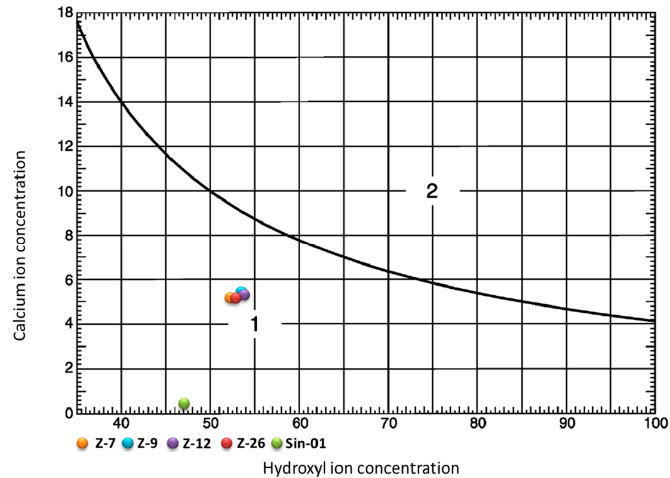
Figure 6. Curve for the results of pozzolanic test.